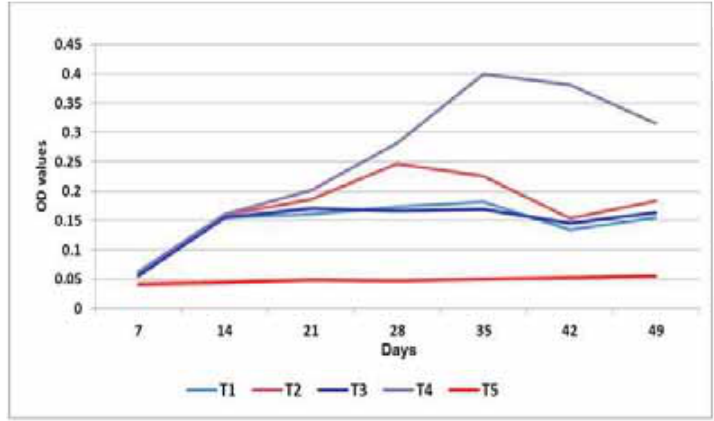
Figure-1: Mean ELISA IgG levels in chickens of experimental